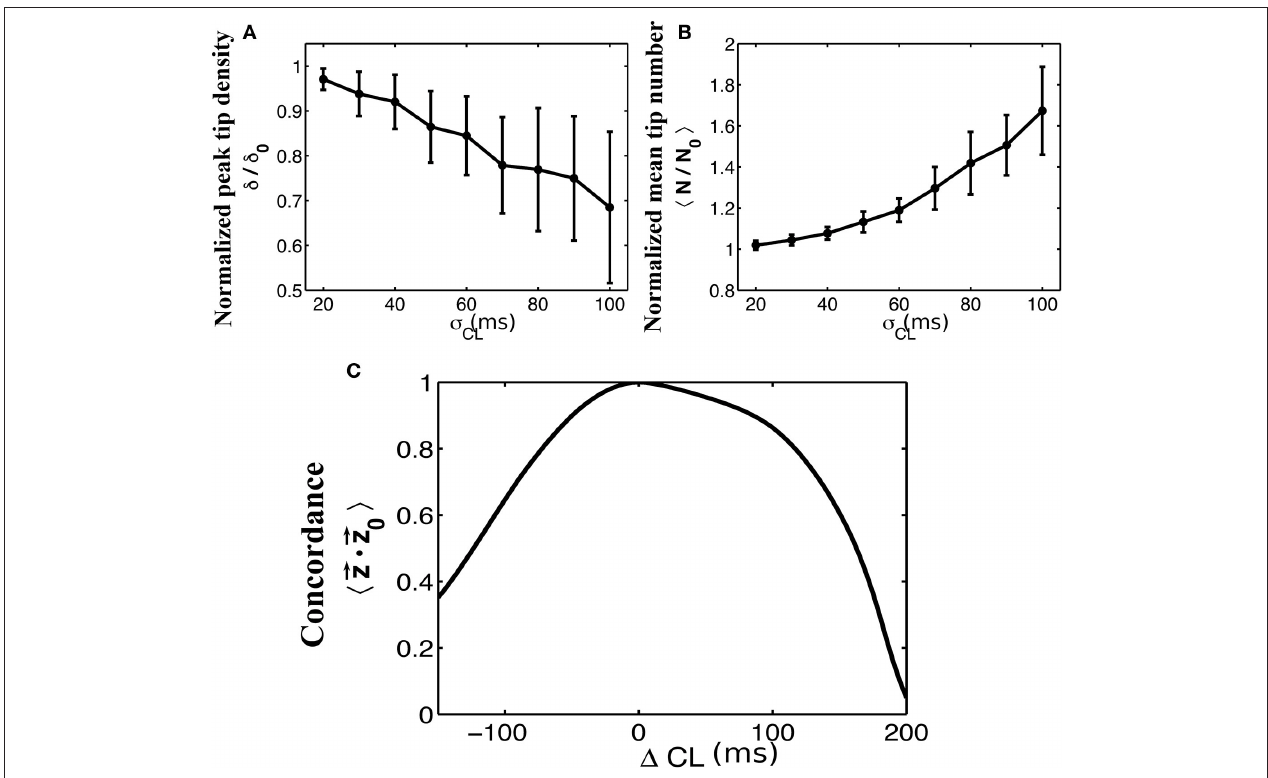
FIGURE 4 | The effects of adding normally distributed noise to the dominant cycle length. Normalized plots of peak tip density around the site of termination (A) , and mean number of tips (B) , as a function of the standard deviation of noise added to the dominant cycle lengths are shown for 50 trials. Error bars show standard deviation. A minimum cycle length of 50ms is used throughout all trials. (C) Mean concordance between the resulting phase vectors ⇀ z 0 after systematically adding values between − 150 and 200 to the originally determined cycle